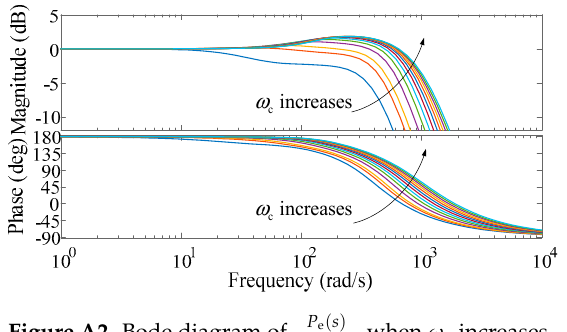
Figure A2. Bode diagram of P e